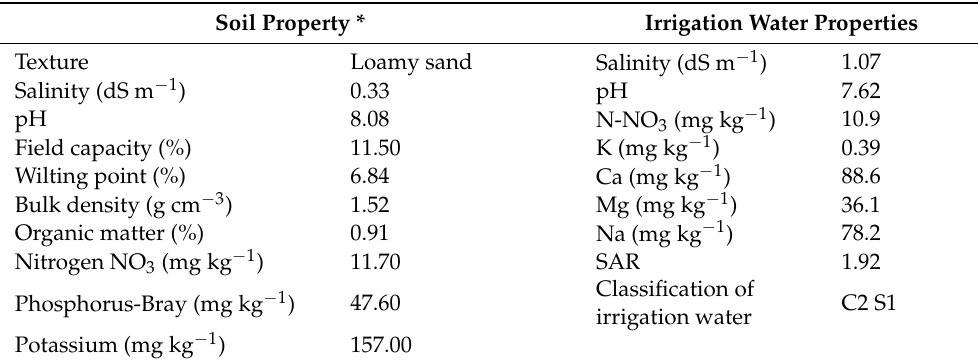
Table 2. Soil and irrigation water properties at the Todos Santos Experimental Station, Baja California Sur, Mexico. Soil Property * Irrigation Water Properties